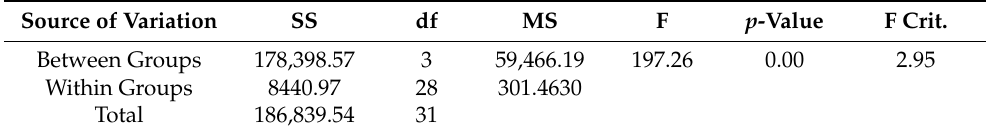
Table 4. ANOVA test of the data in Table 3.